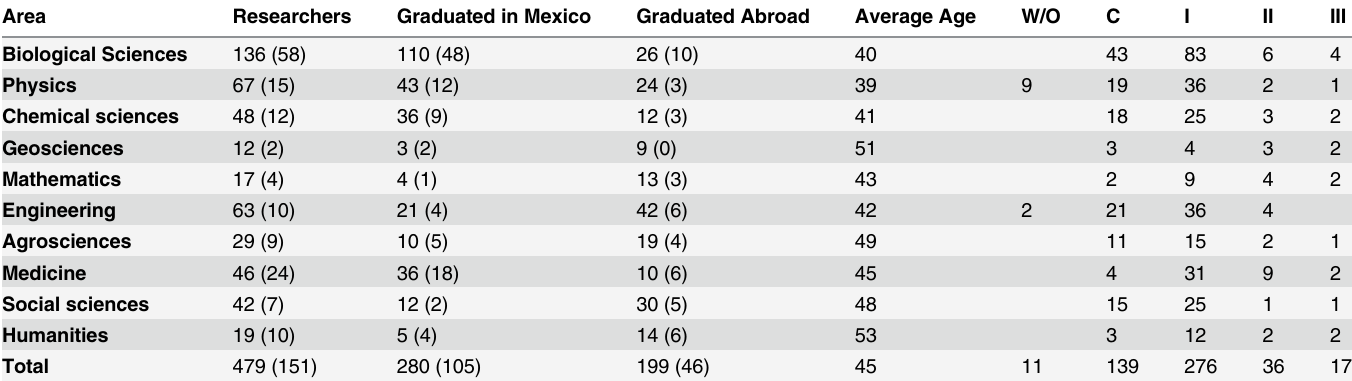
Table 1. Distribution of researchers in the Mexican Diaspora by knowledge area, gender (numbers in parenthesis correspond to female scientists) age average and academic category in the SNI: w/o level, candidate (C), levels I, II and III.